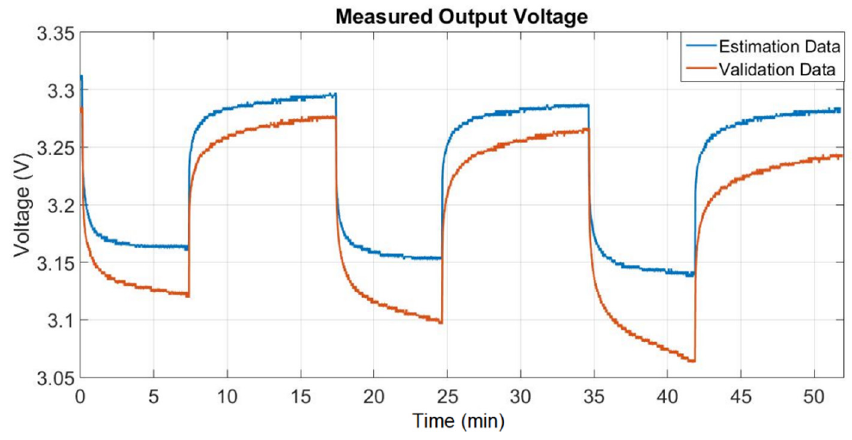
Figure 5. Estimation data (80% to 50% of SOC) and validation data (50% to 20% of SOC).